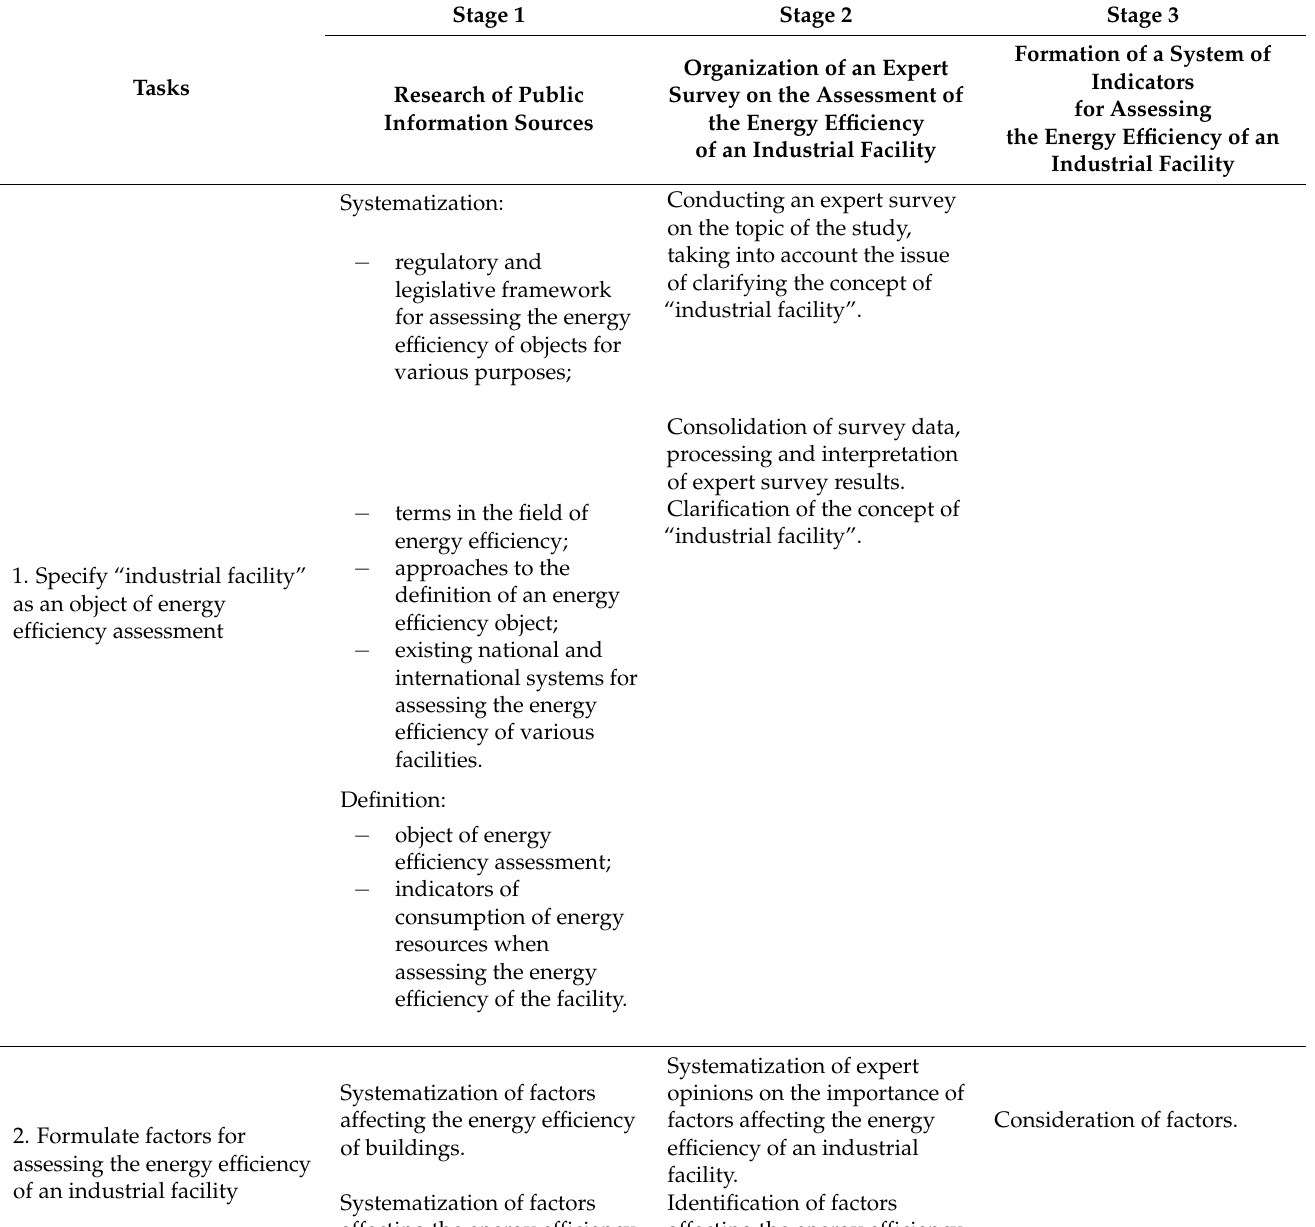
Table 1. Problem-solving